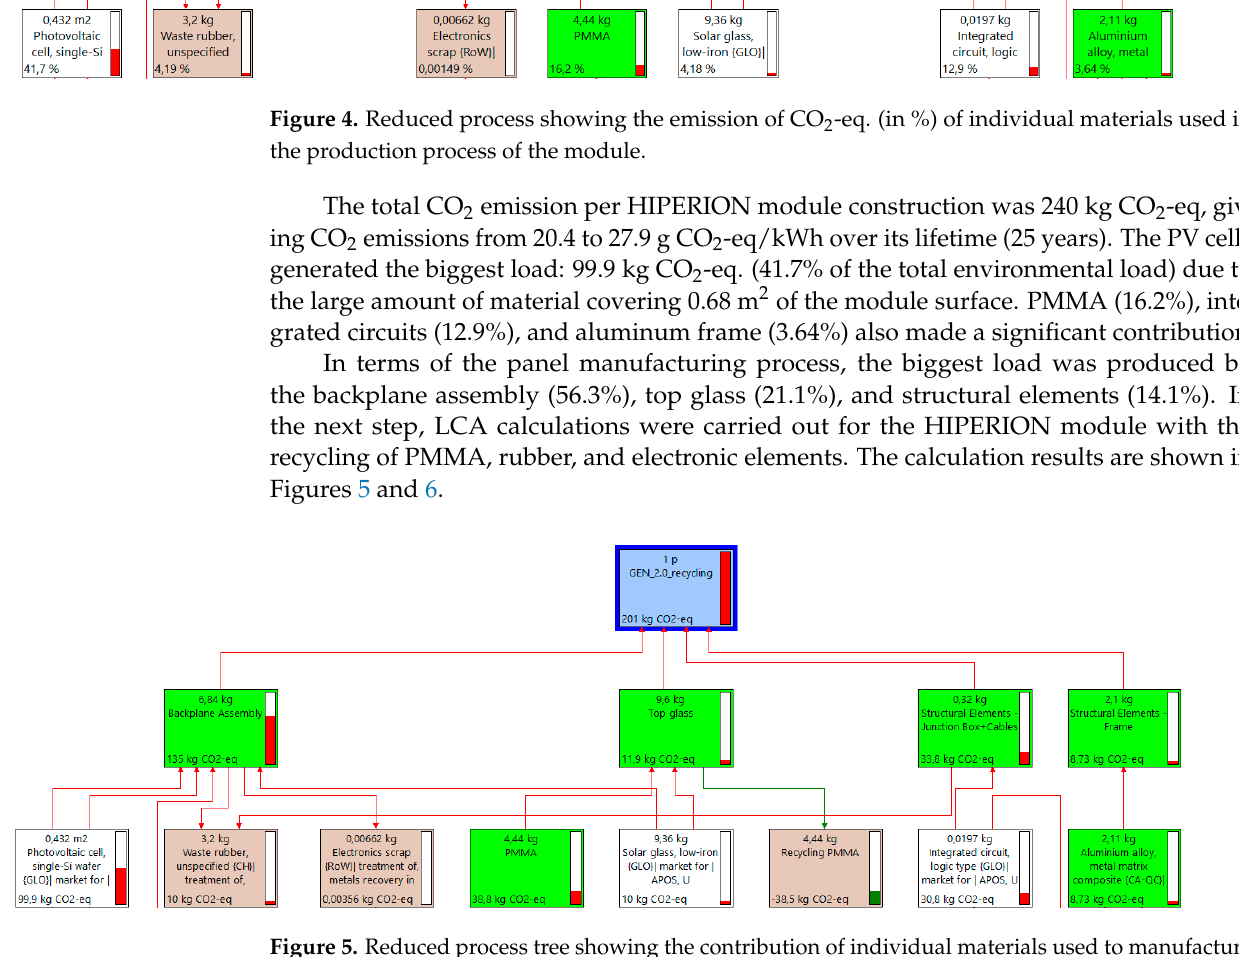
Figure 6. Reduced process tree showing the percentage of contribution of individual materials used to manufacture the module with recycling of PMMA, rubber, and electronic elements (only elements with a contribution higher than 3.5% are shown). Recycling of PMMA, rubber, and electronic components reduced the total environ- mental load of the module by 20%, from 240 to 201 kg of CO 2 -eq. The PV cells generated the greatest environmental load: 99.9 kg of CO 2 -eq., which corresponds to 49.8% of the total environmental load. Reducing the environmental load also decreased the emissions of CO 2 over 25 years of operation from 17.1 to 23.4 g CO 2- eq/kWh per module for di ff erent locations. In terms of system production, the biggest load was produced by the backplane assembly (67.2%), top glass (5.95%), and structural elements (16.7%). The environmental load produced by PMMA was reduced from 38.9 to 0.22 kg CO 2 -eq due to the 100% recy- clability of this material. Figure 7 shows the percentage share of individual components of the module. The largest percentage applies to the backplane (67.2%) and, in particular, PV cells. The share of structural elements at the level of 16.67% is related to the use of integrated circuits and electronic components, both active and passive.